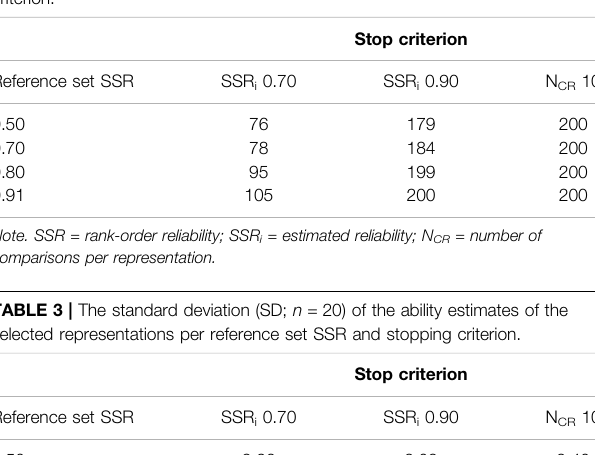
TABLE2| Totalnumberofcomparisonsperreferenceset(SSR)andperstopping